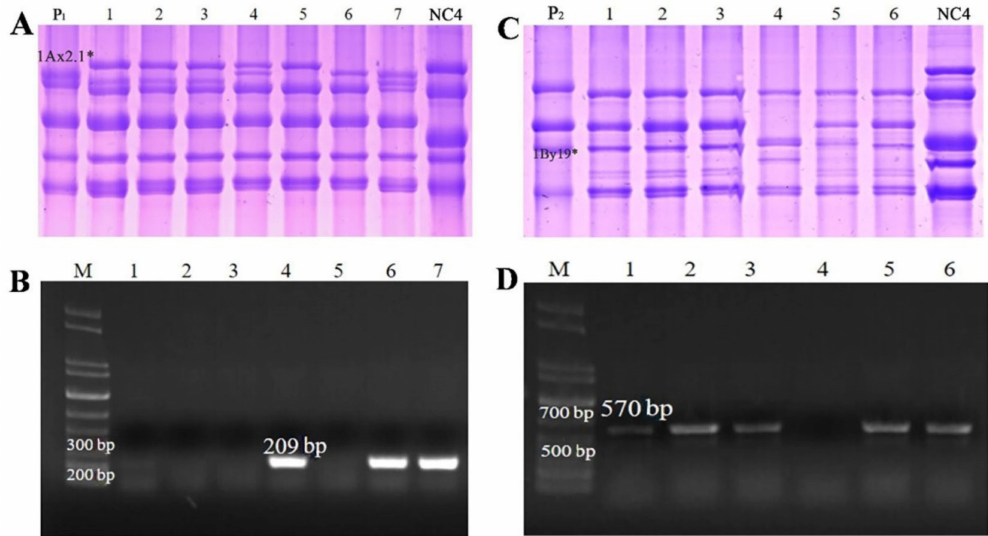
Figure 8. Validation of the SNP-based molecular markers for 1Ax2.1* and 1By19* genes in the RILs derived from Spelt 137 × Ningchun 4 and Spelt 6 × Ningchun 4 crosses. ( A ) HMW-GS from seven RILs (Lanes 1–7) from Spelt 137 × Ningchun 4 identified by SDS-PAGE; ( B ) PCR amplification of 1Ax2.1* gene from seven RILs (Lanes 1–7) of Spelt 137 × Ningchun 4; ( C ) HMW-GS from six RILs (lanes 1–6) from Spelt 6 × Ningchun 4 identified by SDS-PAGE; ( D ) PCR amplification of 1By19* gene from six RILs (lanes 1–6) from Spelt 6 × Ningchun 4. 1Ax2.1* and 1By19* subunits and the special